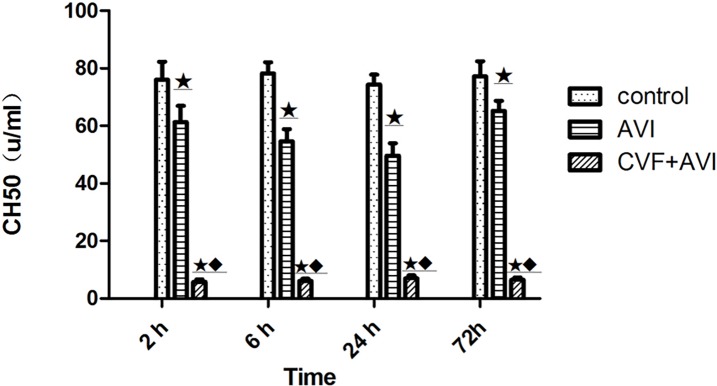
Levels of serum CH50.★ P<0.01 vs. control; ◆ P<0.01 vs. AKI.